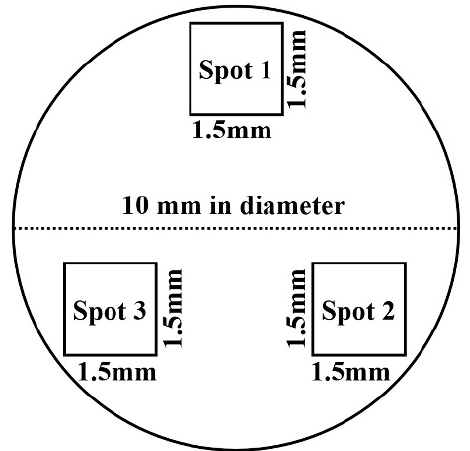
Figure 1. Schematic illustration showing three laser irradiation spots on one specimen.